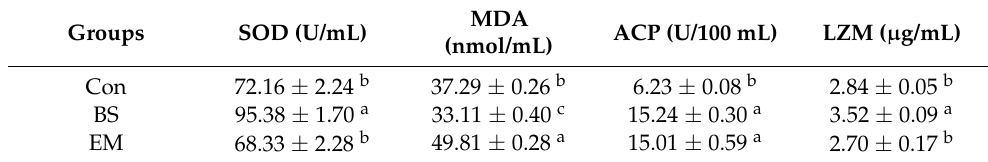
Table 3. Effects of probiotics on plasma immunity of M. rosenbergii .